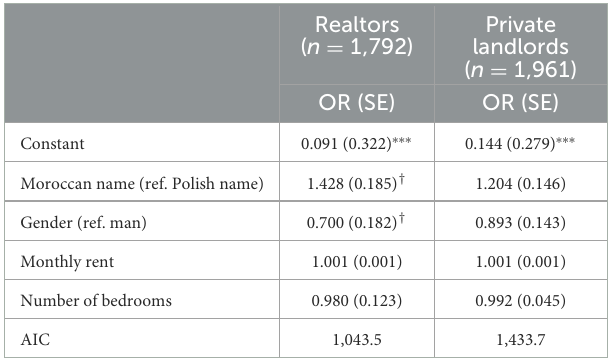
TABLE 4 Binary logistic regression analysis on negative discrimination by ethnic